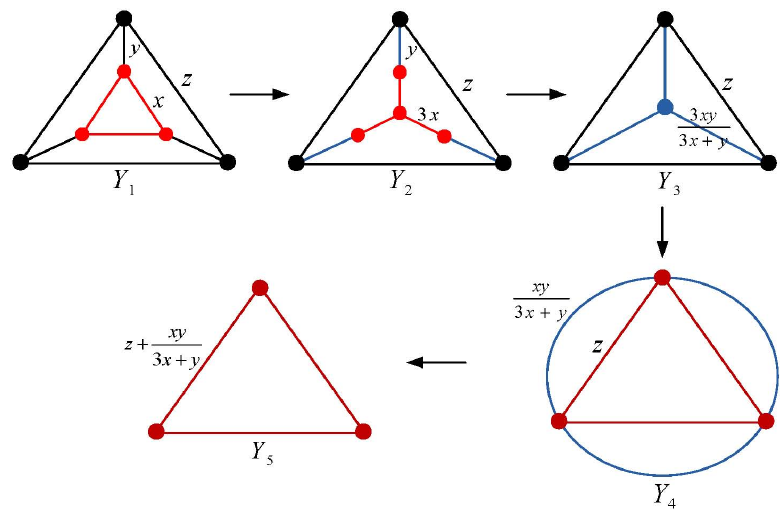
Fig. 5. The transformations from Y 1 to Y 5